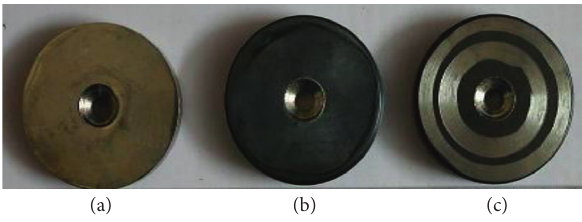
Figure 2: Titanium alloy test samples. (a) Uncoated. (b) Coated. (c) Wear